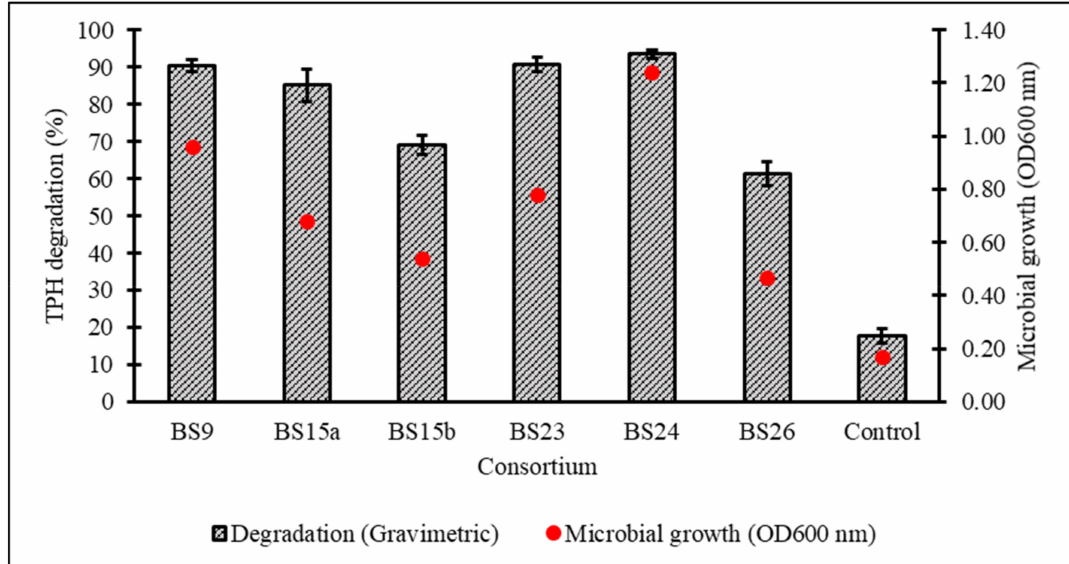
Figure 3. Percentage degradation of TPH and microbial growth (as OD 600nm ) achieved in secondary screening of six selected consortia in standardised BH broth enriched with 2% v / v initial diesel concentration. Error bars represent the mean ± standard deviation for experimental